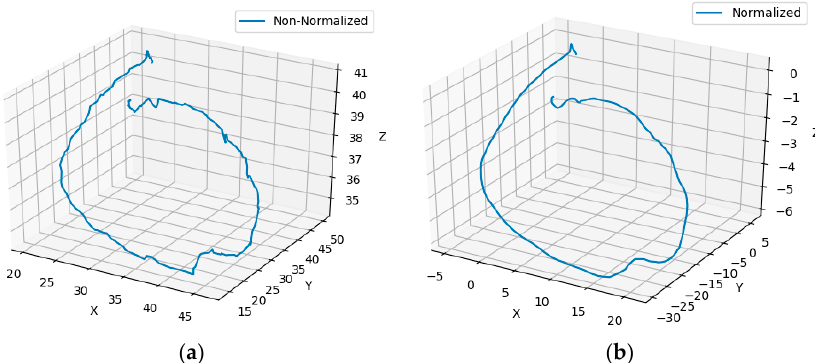
Figure 3. Three-dimensional trajectory visualization: ( a ) sample trajectory before normalization and ( b ) trajectory after normalization.